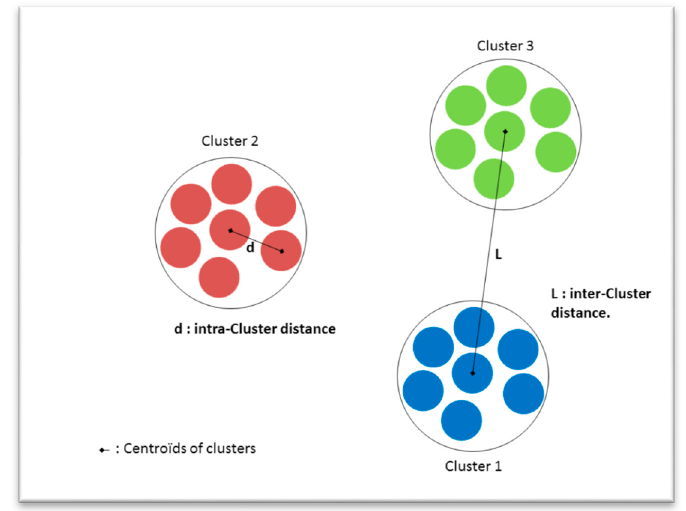
Figure 2. Maximized and minimized distances in a k-means clustering process.